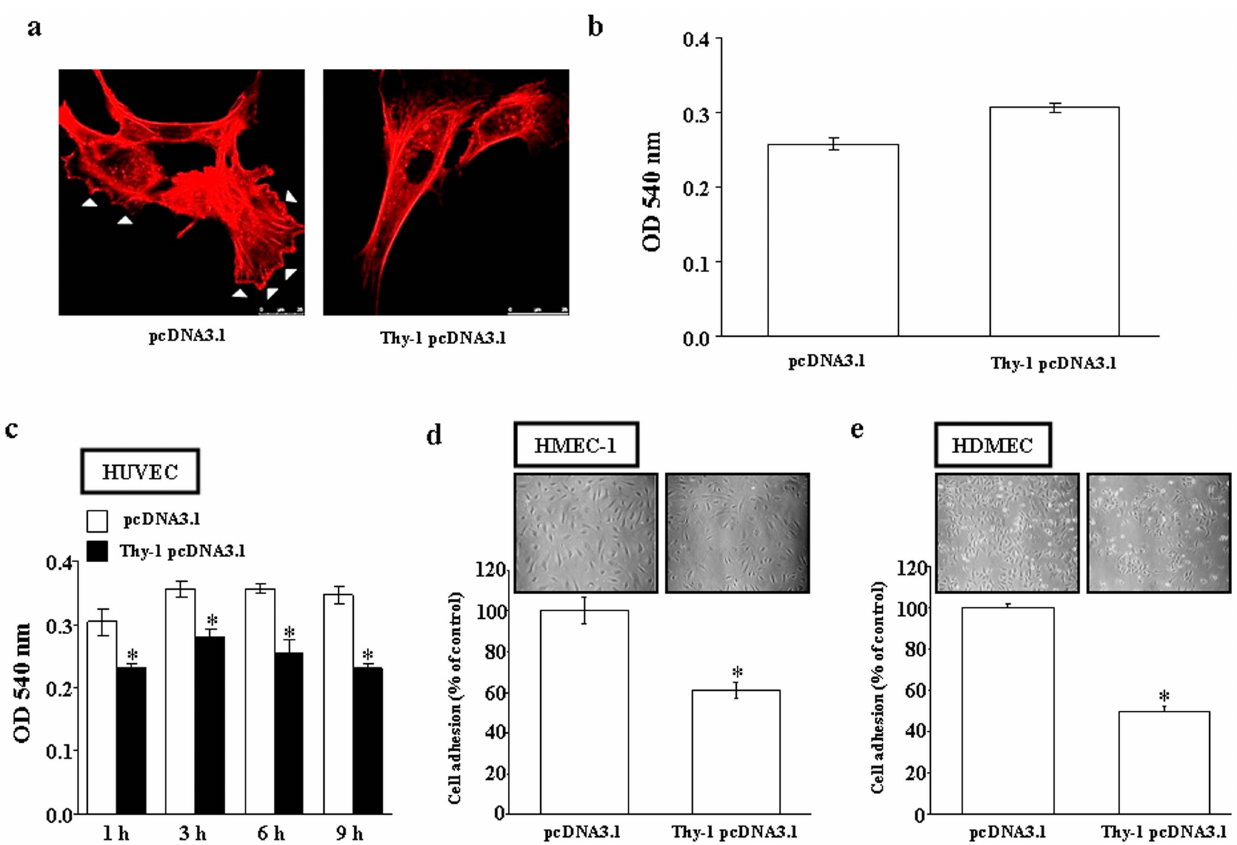
Figure 3. Effect of Thy-1 on lamellipodia formation, and endothelial cell viability and adhesion. (a) Over-expression of Thy-1 inhibited the formation of lamellipodia in HUVEC. HUVEC were tranfected with pcDNA3.1 (control) or Thy-1 pcDNA3.1. At 45 h after transfection, phalloidin staining of HUVEC was then performed as described in the Materials and methods. Scale bar, 25 mm. Triangles indicated the lamellipodia. (b) Over- expression of Thy-1 did not affect the viability of HUVEC. The adhesion of Thy-1-transfected HUVEC to collagen was decreased as compared with vector-transfected HUVEC examined by MTT assay (c) or by cell count (d). (e) This effect was also observed in the HMEC-1 transfected with Thy-1 pcDNA3.1. Values represent the means 6 s.e.mean. (n=4–6). * p , 0.05.